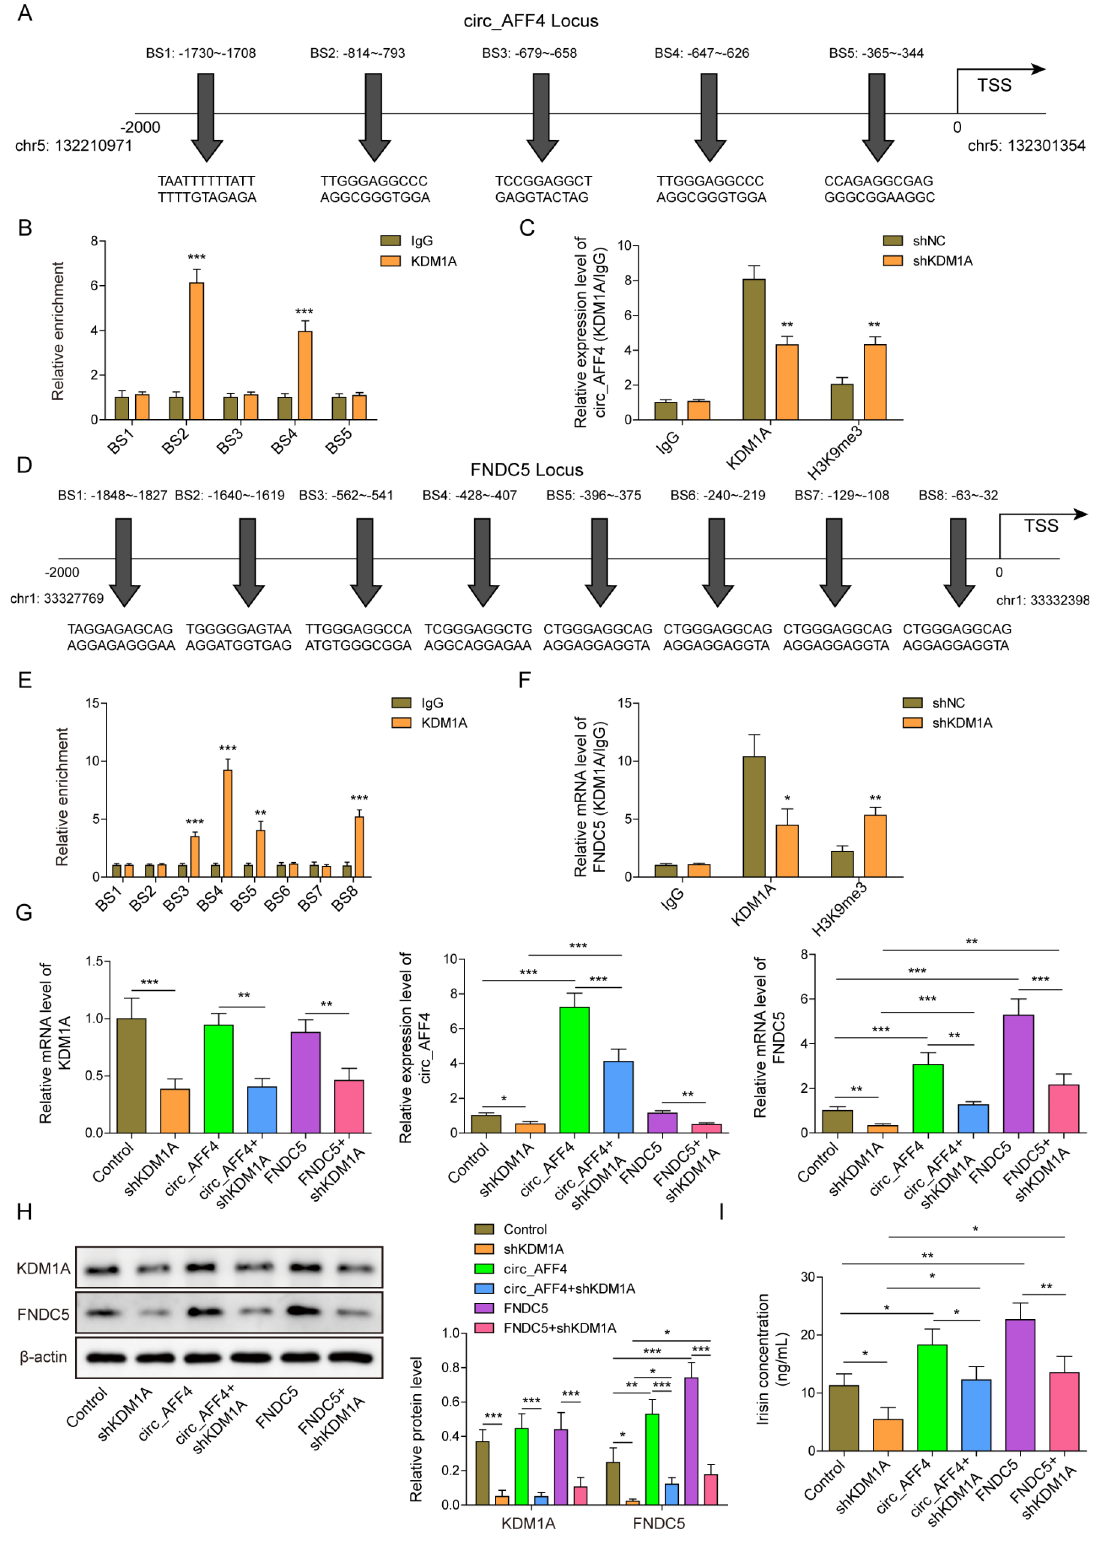
Fig. 6 KDM1A directly binds to circ_AFF4 and FNDC5 to promote FNDC5/Irisin expression ( A ) Schematic illustration showing binding sites between circ_AFF4 promoter and KDM1A predicted by AnimalTFDB, ( B ) ChIP assay showing the enrich- ment of BS1-5 sites of circ_AFF4 promoter in complexes precipitated with antibody against KDM1A. ( C ) ChIP assay showing the impact of KDM1A knock- down on KDM1A/circ_AFF4 promoter interaction. ( D ) Schematic illustration showing binding sites between FNDC5 promoter and KDM1A predicted by AnimalTFDB, ( E ) ChIP assay showing the enrichment of BS1-8 sites of FNDC5 promoter in complexes precipitated with antibody against KDM1A. ( F ) ChIP assay showing the impact of KDM1A knockdown on KDM1A/FNDC5 promoter interaction. Circ_AFF4, FNDC5 and KDM1A were detected by ( G ) RT-qPCR and ( H ) western blot. ( I ) ELISA detected Irisin expression. * p < 0.05, ** p < 0.001 and *** p < 0.001. Each experiment was performed at least three times